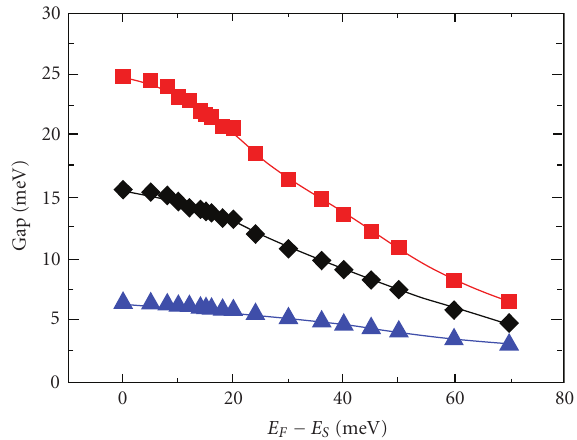
Figure 9: Variation of the various gaps Δ max , Δ min , Δ av versus the doping linked to E F - E S at T = 0K red square symbol = Δ max , black diamond symbol = Δ av , blue up triangle symbol = Δ min .